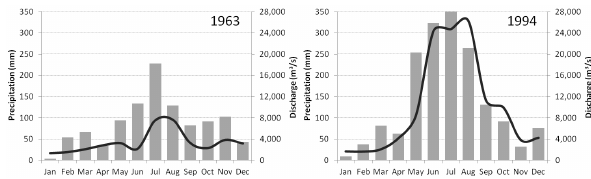
Fig. 4. Average monthly precipitation (grey bars) in the Xijiang River basin and average monthly discharge (black line) at Gaoyao hydrological station in 1963 (left) and 1994 (right).